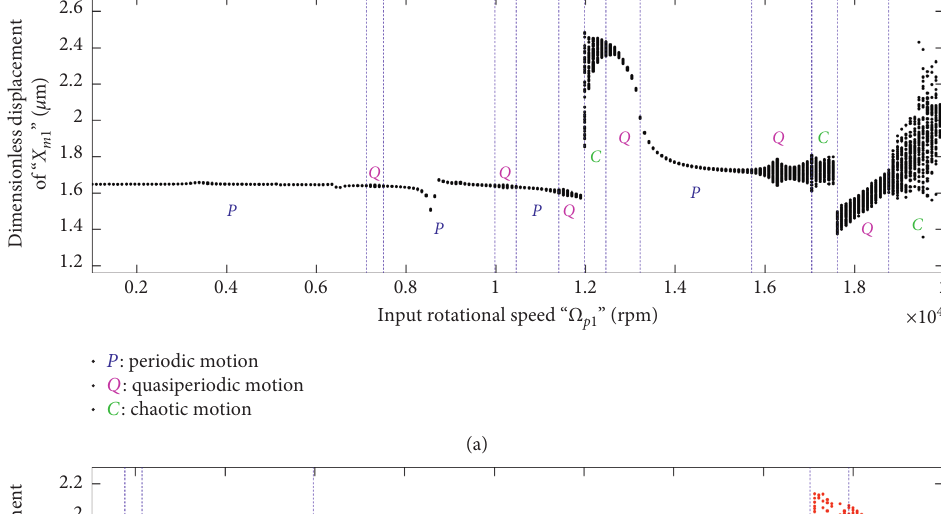
s � s � 40 μ m. (a) X 1 2